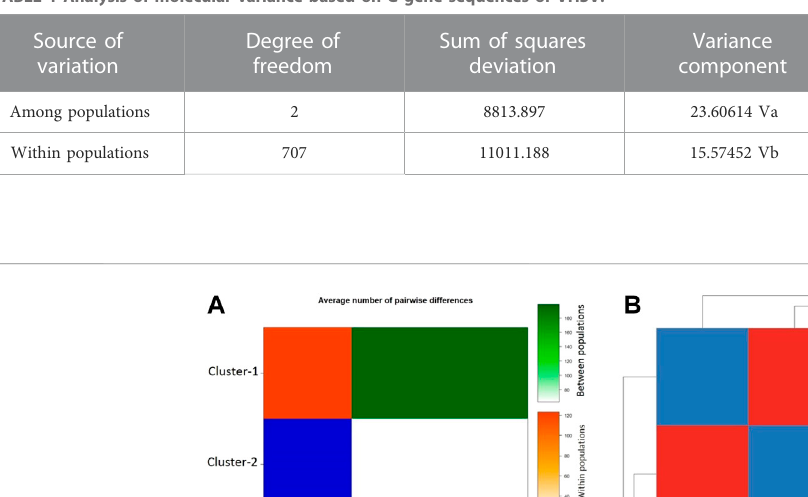
TABLE 1 Analysis of molecular variance based on G -gene sequences of VHSV.